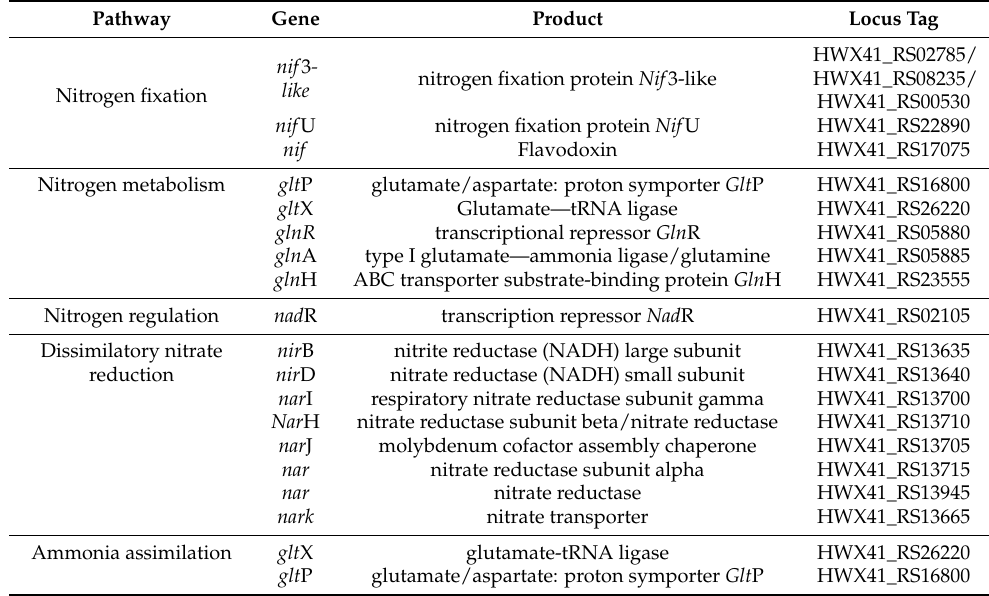
Table 2. Genes involved in nitrogen fixation and nitrogen metabolism.